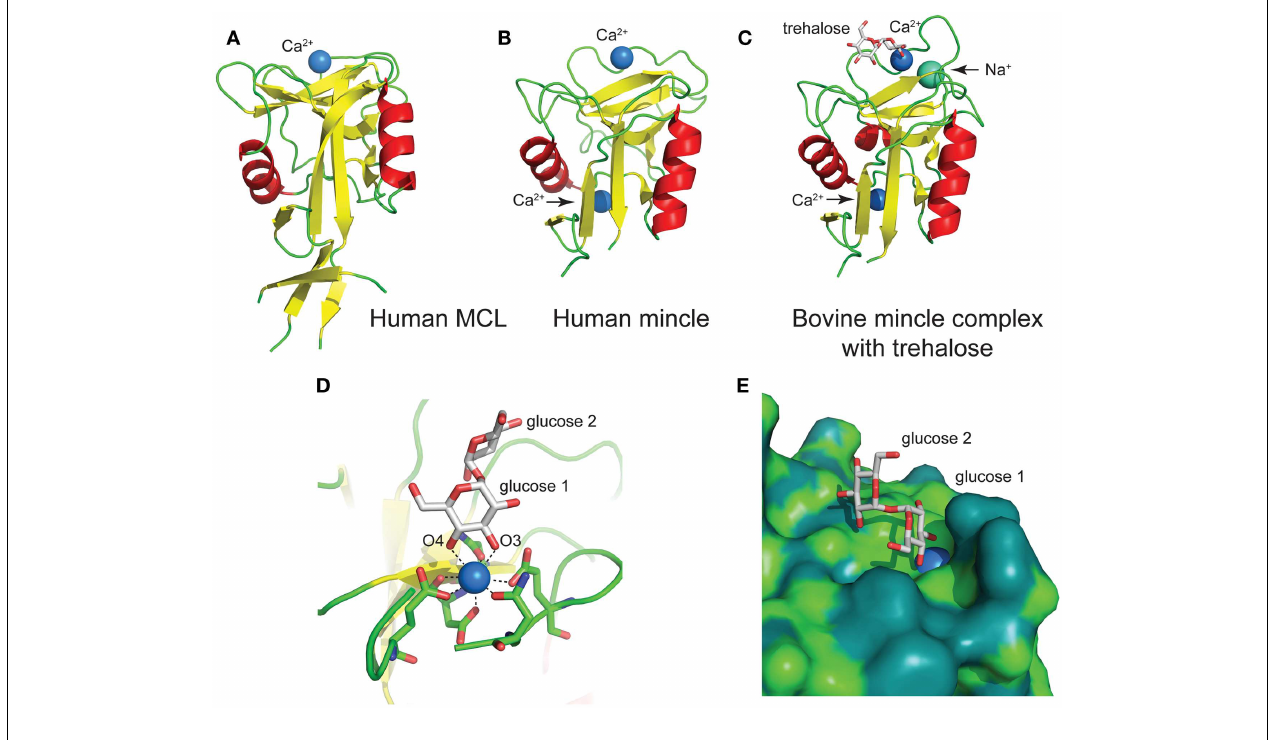
FIGURE 5 | Structures of the C-type lectin domains of (A) human MCL (PDB: 3whd); (B) human Mincle (PDB: 3wh3); (C) bovine Mincle complex with trehalose (PDB: 4kzv); (D) interactions with Ca 2 + at the primary glucose binding site of bovine Mincle; and (E) putative